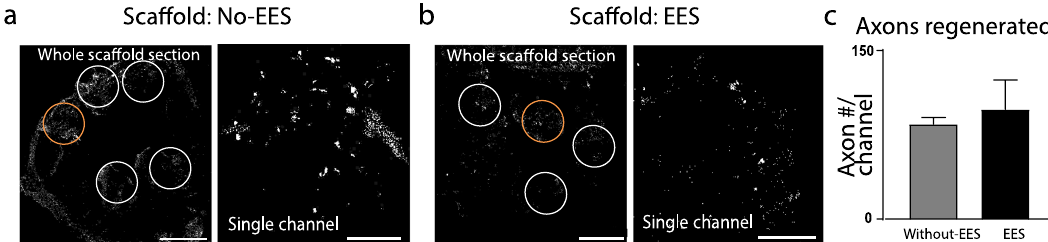
Fig. 2 Axon regeneration through implanted scaffolds 7 weeks after injury. a Transverse section (10 µm thick) through a scaffold implanted in a rat that did not receive EES and b transverse section in rat that received EES-enabled motor training. The sections were fi xed and stained with β -tubulin 7 weeks of post-implantation and axons were visualized and quanti fi ed in the channels (white circles) (scale bar = 400 μ m. The channels in the orange circles are presented in higher magni fi cation on the right (scale bar = 50 μ m). c The number of axons passing through the scaffold shows no statistical difference between group without EES ( n = 3) and group that received EES-enabled motor training ( n = 5) ( t -test). Error bars: + / − standard error of the mean